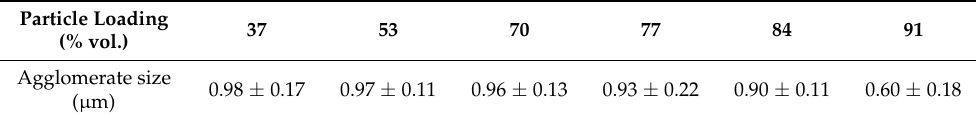
Table 2. Agglomerate Size of the Coatings by Image J Figure 5. SEM image of coatings with different particle loadings.